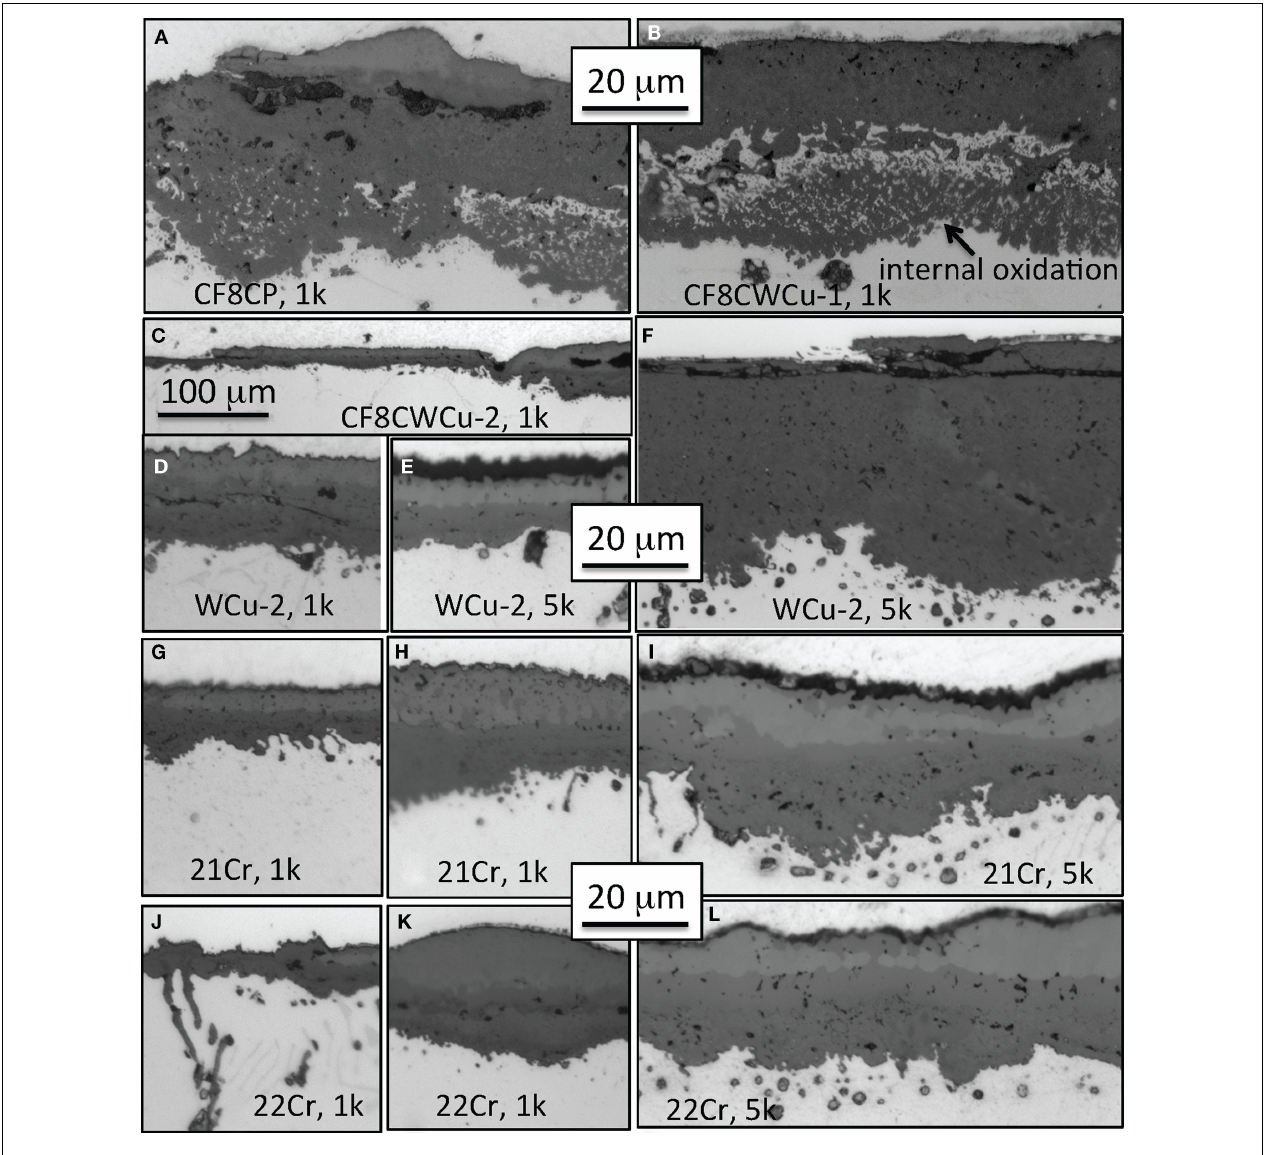
FIGURE 11 | Cross-section optical micrographs after exposure in air +++ 10%H 2 O at 800°C, (A) CF8CP alloy for 1000h, (B) CF8CWCu-1 alloy for 1000h, (C,D) CF8CWCu-2 alloy for 1000h,